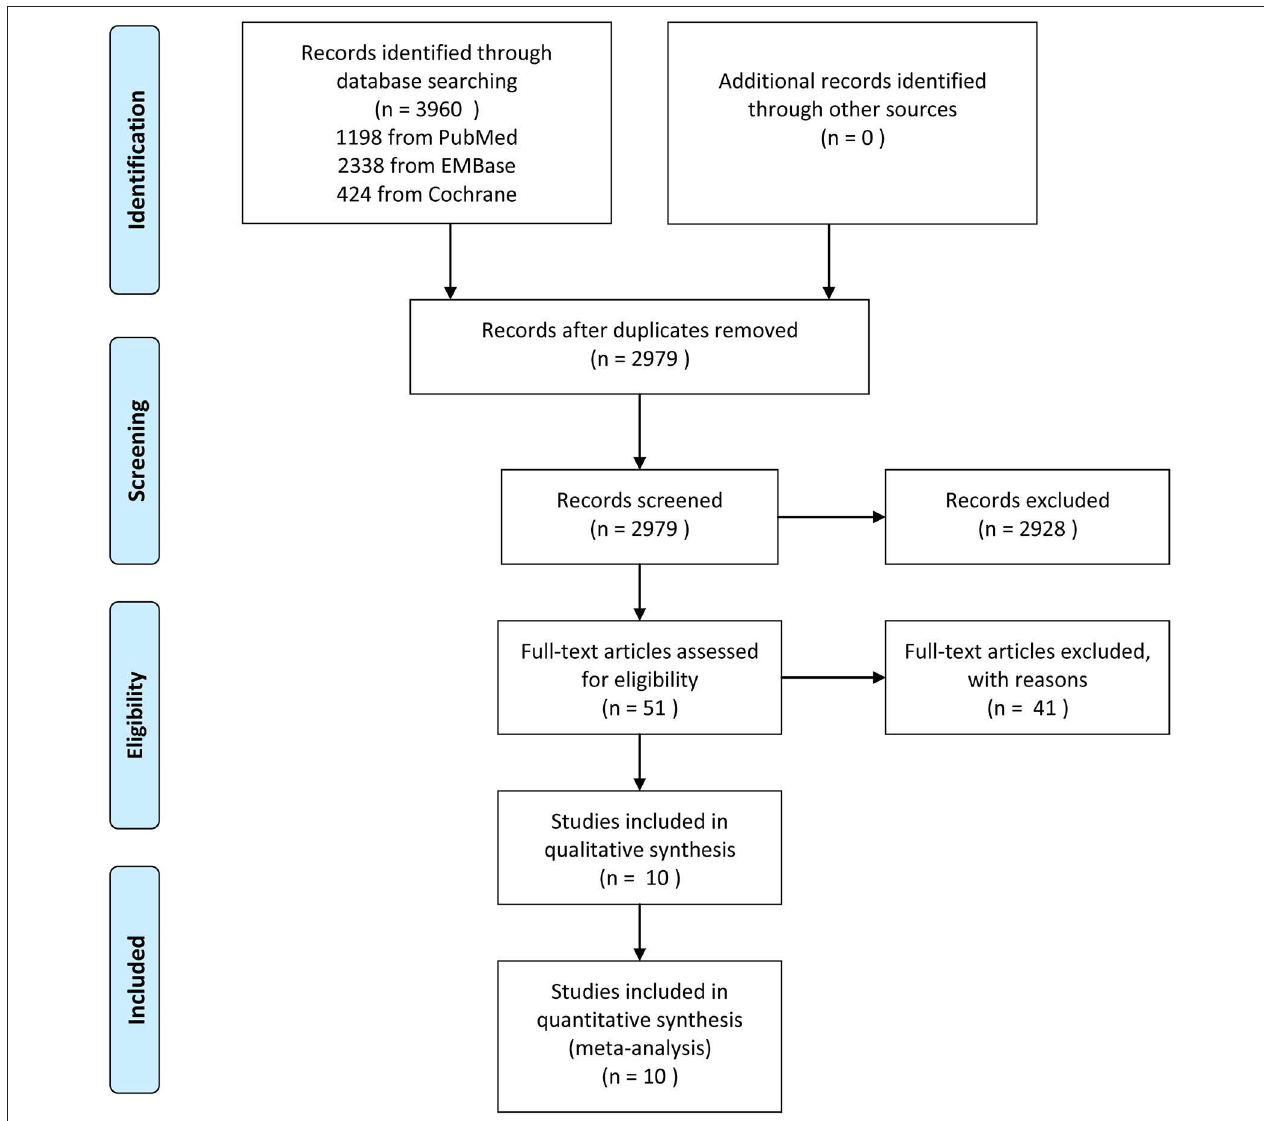
FIGURE 1 | Outline of screening and identification of studies.